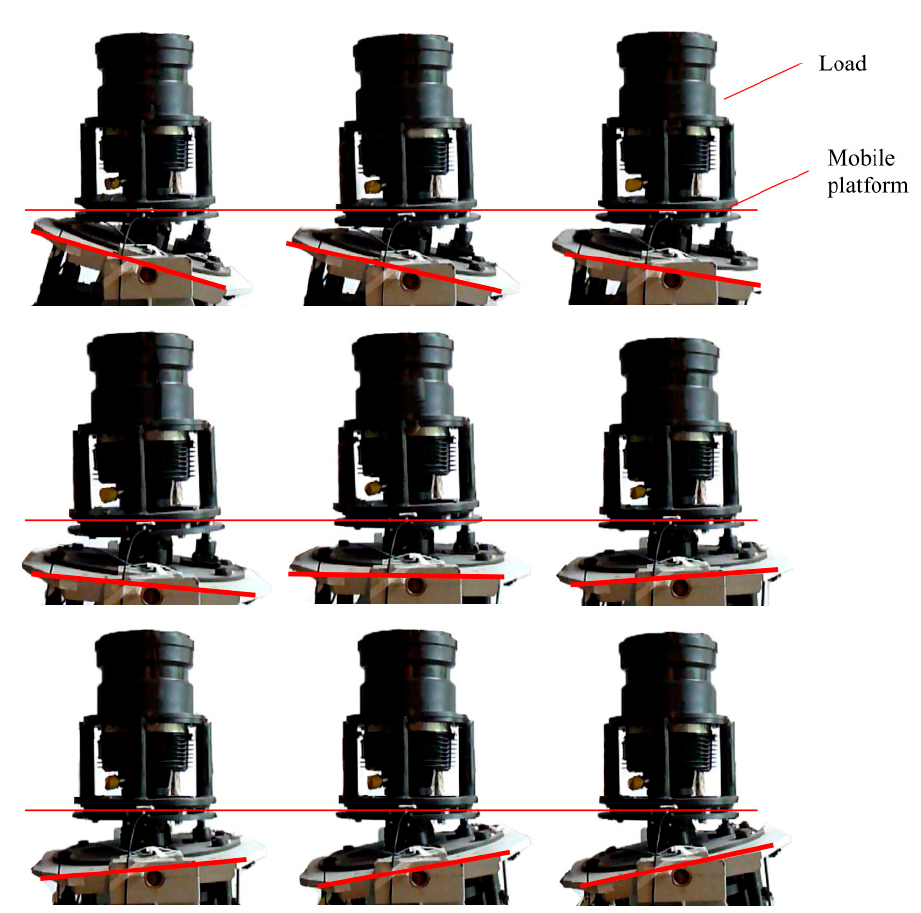
Figure 11. Dynamic leveling test of the platform.